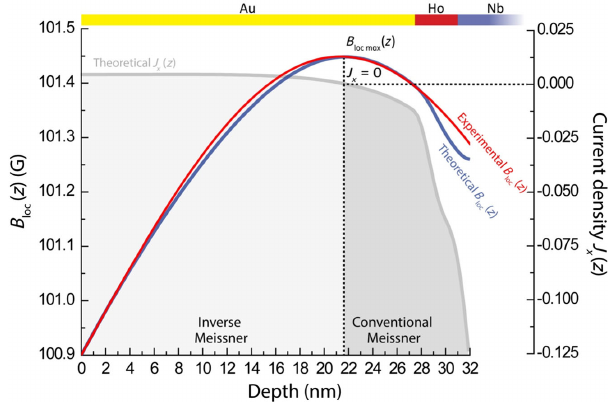
FIG. 3. Magnetization and screening current profile from the Ho = Nb interface in Au = Ho = Nb. Local magnetic field B determined as global-energy fit of the LE- μ SR measurement data (red curve, left y axis) and theoretical model (blue curve, left y axis); calculated dimensionless screening current density J flowing parallel to the x axis in Fig. 1(a) inside the plane of the thin film heterostructure (gray curve, right y axis). Dashed lines show that the position of the maximum in B that of the null in J x ð z Þ